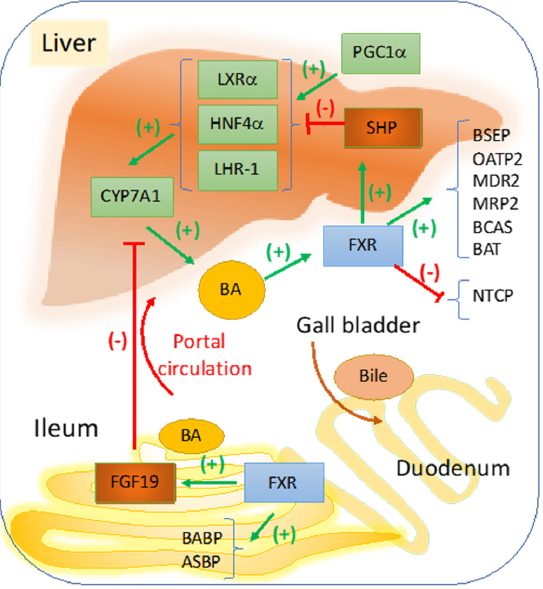
Figure 1. FXR regulation of bile acid synthesis, transport and hepato-enteric circulation. Cyp7a1 is the rate limiting enzyme in BA synthesis, and it is transactivated by LXR α , HNF4 α , and LHR-1 which in turn are stimulated by various ligands derived from lipid nutrients including cholesterol (for LXR α ), fatty acyl-CoA (for HNF4 α ), dietary phospholipids for LRH-1 or liver receptor homologue-1 [18,19]. When BA becomes abundant in the liver, a negative feedback loop starts to function via FXR to maintain balance and to control the elimination of excess BA. BA-induced activation of FXR results in upregulation of SHP which is a co-repressor of LXR α , HNF4 α , and LHR-1. FXR upregulates genes with role in BA conjugation, i.e., BA CoA synthase (BCAS) and BA CoA: amino acid N- acetyltransferase (BAT). FXR mediates the bile formation and flow from the liver to the gallbladder by upregulating bile salt export pump (BSEP, ABCB11) which exports BA from hepatocytes; multidrug resistance associated 2 (MRP2, ABCC2) for the transport of BA amongst many other components of the bile into the gallbladder. Other proteins such as multidrug resistance protein 2 (MDR2), a transporter of phospholipids, and ABCG5, ABCG8 that transport cholesterol to the gallbladder are also upregulated by FXR. In the intestine, FXR transactivates ileum BA binding protein (IBABP) and mediates BA reabsorption by apical sodium-dependent bile salt transporter (ASBT). From portal circulation BA are reabsorbed into hepatocytes via sodium-dependent taurocholate cotransport peptide (NTCP), and organic anion transport protein 2 (OATP2). In the intestine, BA-activated FXR upregulates FGF19, a growth factor that is secreted into the portal circulation and inhibits Cyp7a1- controled BA synthesis in hepatocytes. BA synthesis is upregulated when BA concentration in the liver is low and SHP is replaced by PGC1 α co-activator of genes that stimulate Cyp7a1 synthesis